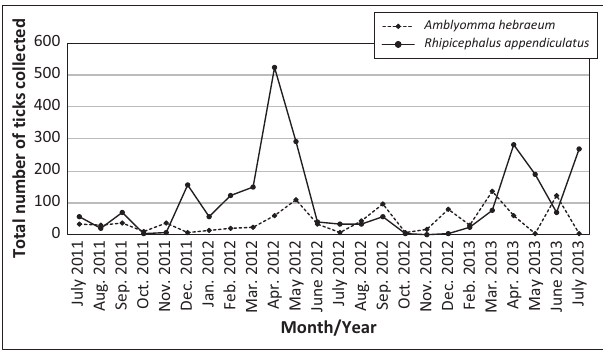
FIGURE 2: Total numbers of Rhipicephalus decoloratus and Rhipicephalus evertsi evertsi larvae collected between July 2011 and July 2013 by monthly drag- sampling of the vegetation on the farm Hoopdal KQ96 between July 2011 and July 2013.